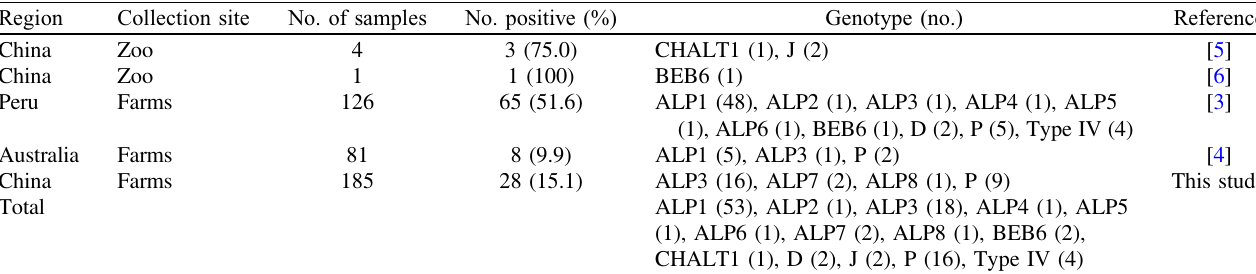
Table 2. Summary of known Enterocytozoon bieneusi genotype distributions in alpacas